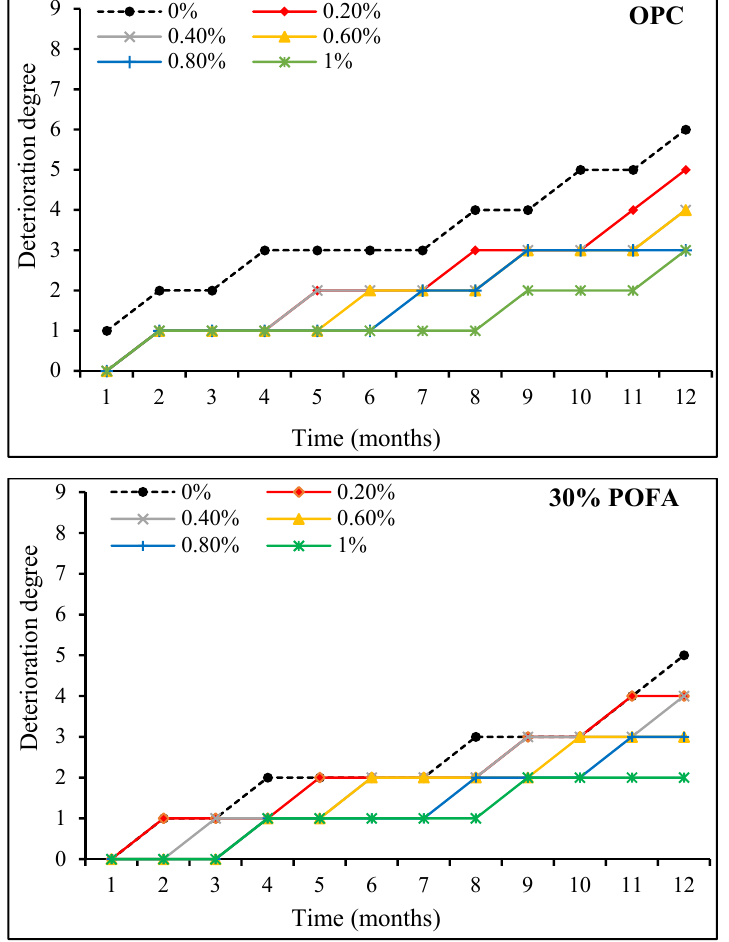
Figure 5. Deterioration degree of concrete specimens reinforced with WPFT fibers exposed to MgSO 4 solutions.